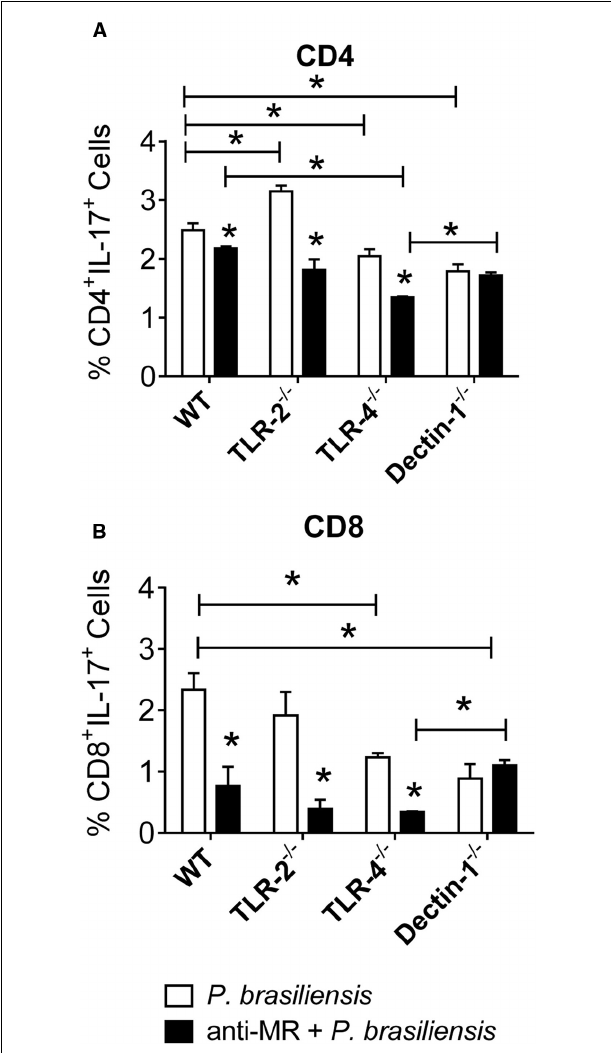
FIGURE 8 | MR collaborates with TLR-4 in the development of IL-17 producing cells. BMDCs from WT, TLR-2 (cid:0) / (cid:0) , TLR-4 (cid:0) / (cid:0) , and Dectin-1 (cid:0) / (cid:0) mice were cultured and then treated or not with anti-MR antibody for 30 min, and infected with viable P. brasiliensis yeasts for 2 h. Splenic lymphocytes from uninfected WT, TLR-2 (cid:0) / (cid:0) , TLR-4 (cid:0) / (cid:0) , and Dectin-1 (cid:0) / (cid:0) mice were co-cultures with anti-MR treated or untreated DCs. After 5 days, the cells were adjusted to 1 (cid:2) 10 6 and re-stimulated with PMA/ionomycin for 6 h, labeled with specific anti-CD4 (A) and CD8 (B) antibodies and subjected to intracellular staining for IL-17. The cells were analyzed by flow cytometry, and lymphocyte population gated by FSC/SSC analysis. The results are expressed as frequency of positive cells. Data are means (cid:6) SD of five wells per group from three independent experiments (* P <